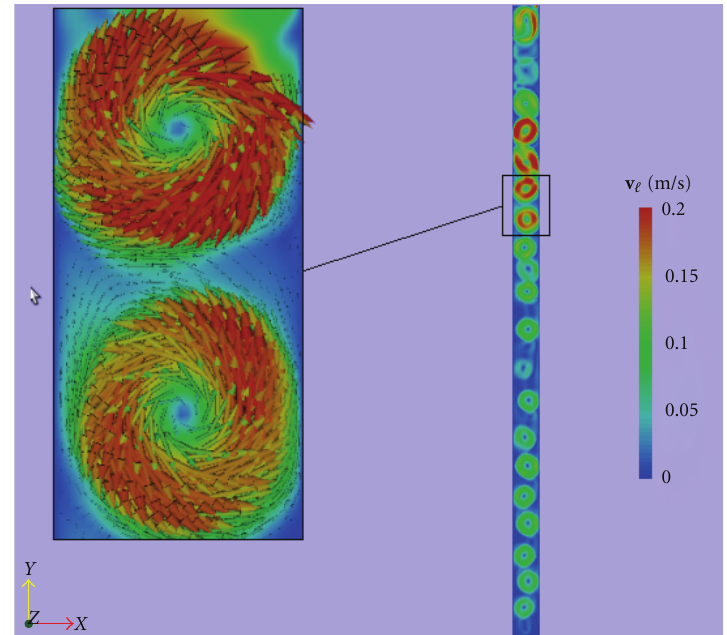
Figure 6: Instantaneous liquid velocity magnitude in Geometry 1 (vector representation in detail).